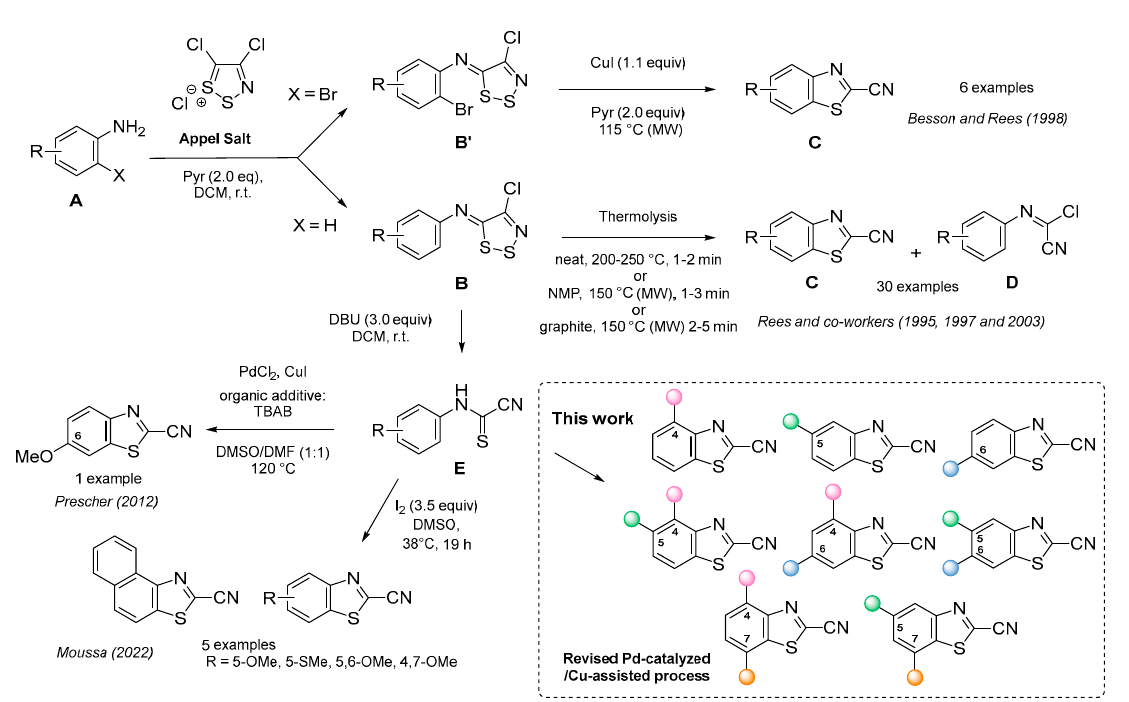
Figure 1. Synthesis of 2-cyanated benzothiazoles from 5- N -arylimino-4-chloro-1,2,3-dithiazoles and N -arylcyanothioformamides and description of the present work. References involved in these studies: [47,48,51,52,55,57].